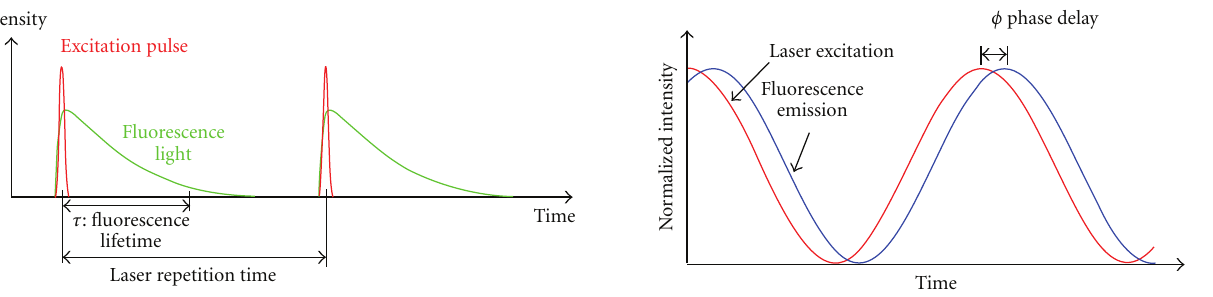
Figure 4: Illustration of frequency-domain fluorescence lifetime measurement. The excitation light (red) is modulated in amplitude at a frequency ω , while the fluorescence light (blue) is emitted with the samemodulationfrequency but with a phaseshift in time, φ. For a single exponential lifetime, the value of the fluorescence lifetime is related by tan φ = ωτ